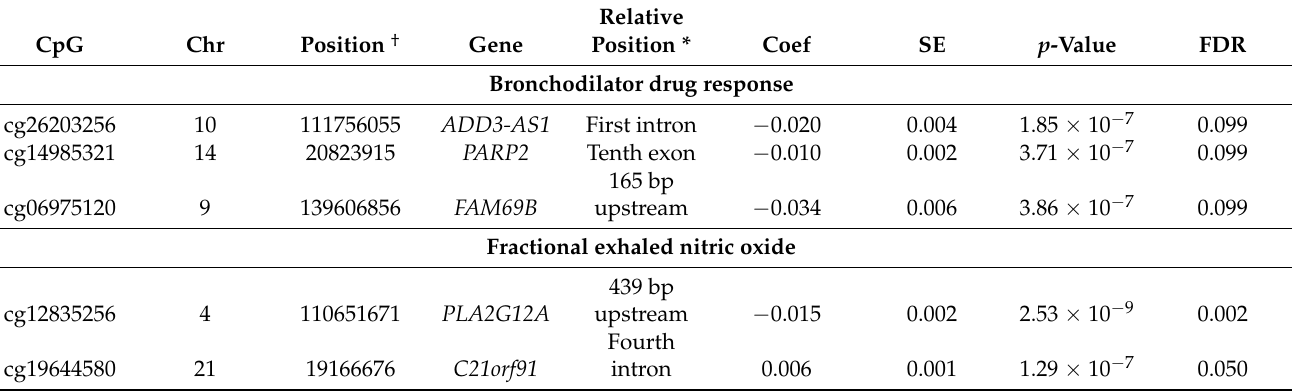
Table 2. Summary results of the epigenome-wide association